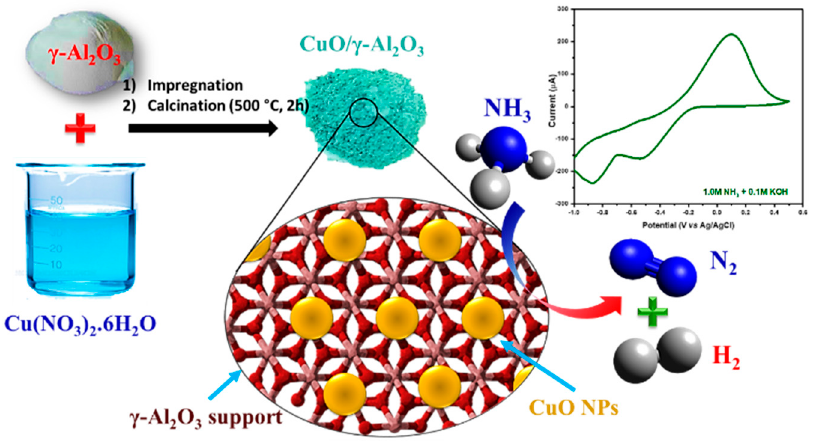
Figure 1. Graphical abstract for the synthesis of CuO/ γ -Al 2 O 3 nanomaterials for ammonia electro- Figure 1. GraphicalabstractforthesynthesisofCuO/ γ -Al 2 O 3 nanomaterialsforammoniaelectro-oxidation. oxidation.